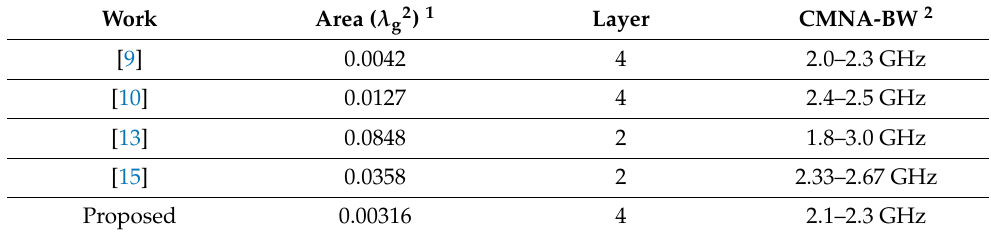
Table 4. Area Comparison with Reference of Unidirectional